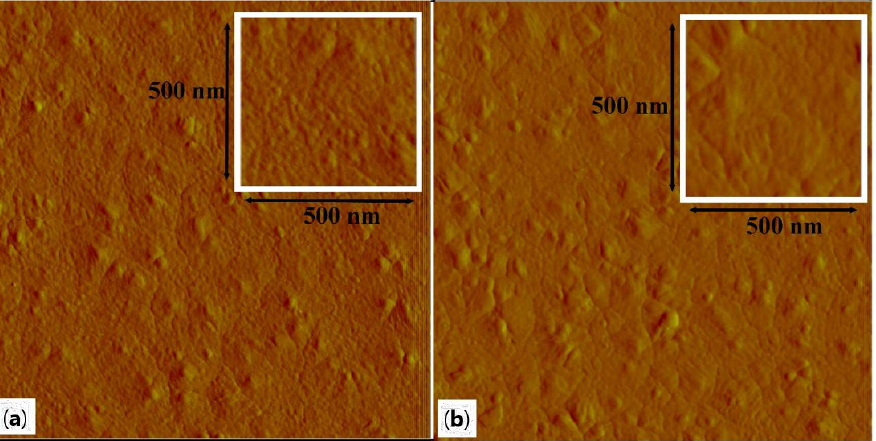
Figure 4. AFM images (2 µ m × 2 µ m) of WO 3 films annealed at 400 ◦ C ( a ) and 500 ◦ C ( b ) for 6 h. Insets: zoomed AFM images (500 nm × 500